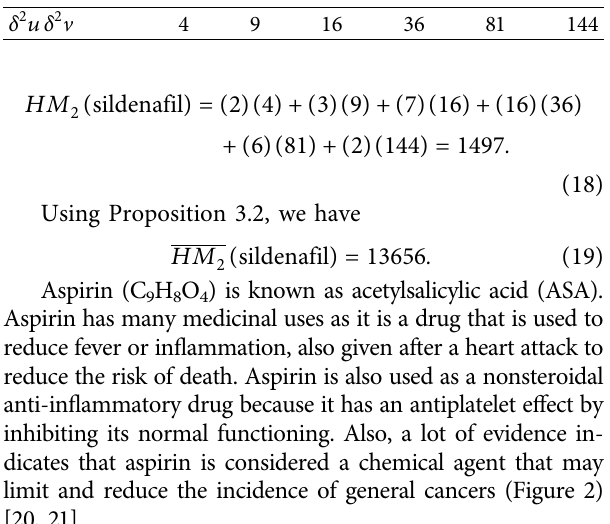
Table 2: Links dataset of the graph structure of sildenafil. No. of links